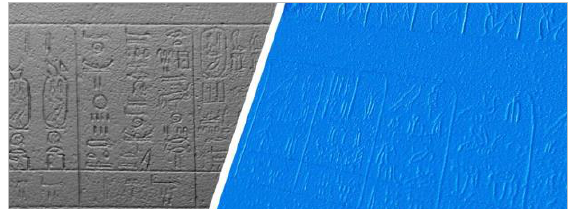
Figure 4: 3D scanning and data registration processing steps: registration and merging point